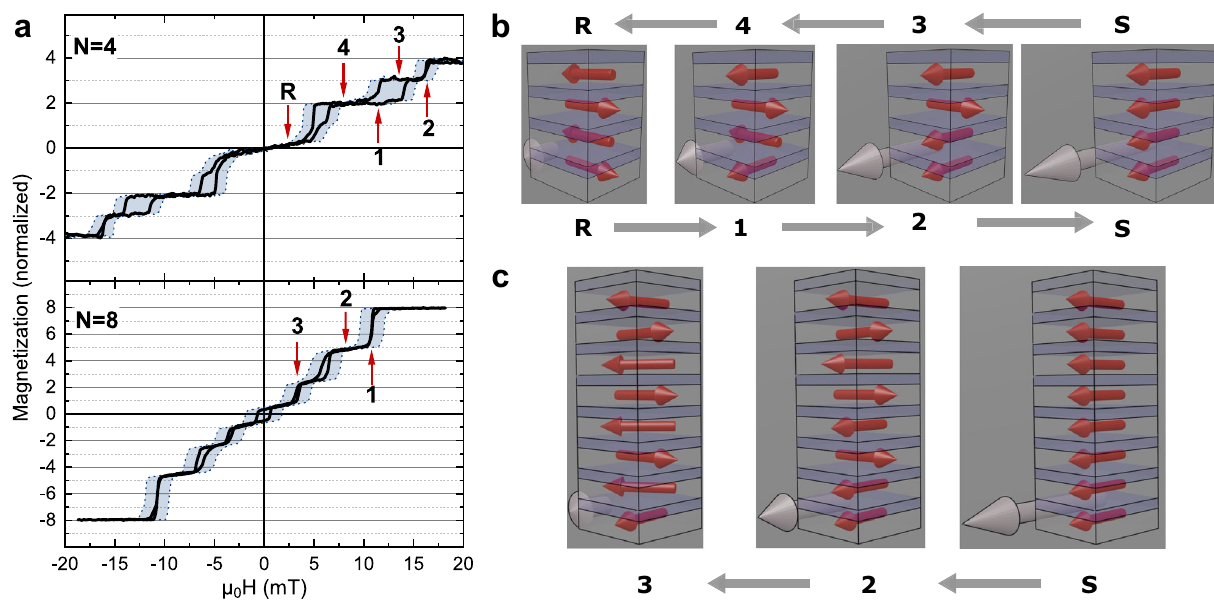
Figure 3. ( a ) Representative results from magnetization measurements along the in-plane easy axis (Fe[100]) of a [Fe/MgO] 4 and a [Fe/MgO] 8 multilayer. The outline of the blue areas marks the measured hysteresis loops whereas in the black curves the coercivity of the Fe layers has been removed. The arrows and the symbols refer to the external fields used in the neutron experiments. ( b ) Schematic illustration of the field dependent magnetic ordering obtained from fitting the N = 4 PNR data (the angles are rounded off to the nearest easy axis) with S being the saturation. When a field is applied, the outermost layers switch first (R → 1), becoming parallel to the applied field. When the field is decreased, the outermost layers are the last to return to the AFM state (4 → R). ( c ) Schematic illustration of the magnetic arrangement obtained from fitting the N = 8 PNR data. See supplementary information for the PNR data and the values obtained from the